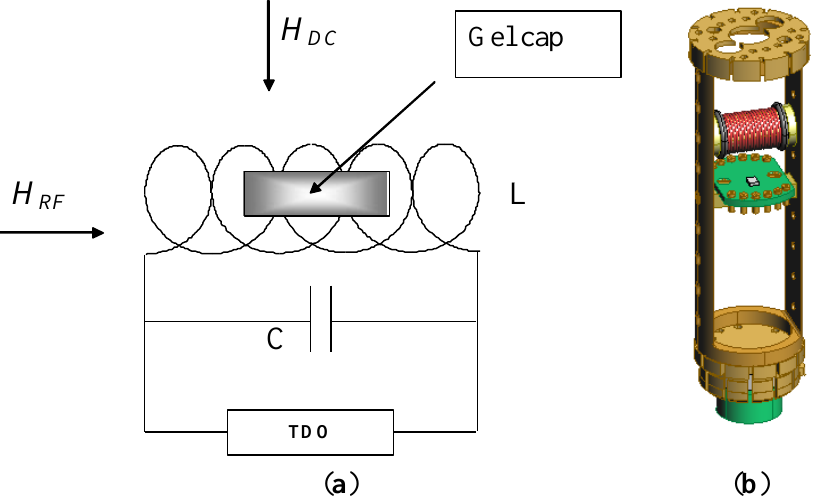
Figure 4. Schematic of the TDO circuit and sample space ( a ) and computer-aided design (CAD) drawing of the inductance coil which serves as the sample holder ( b